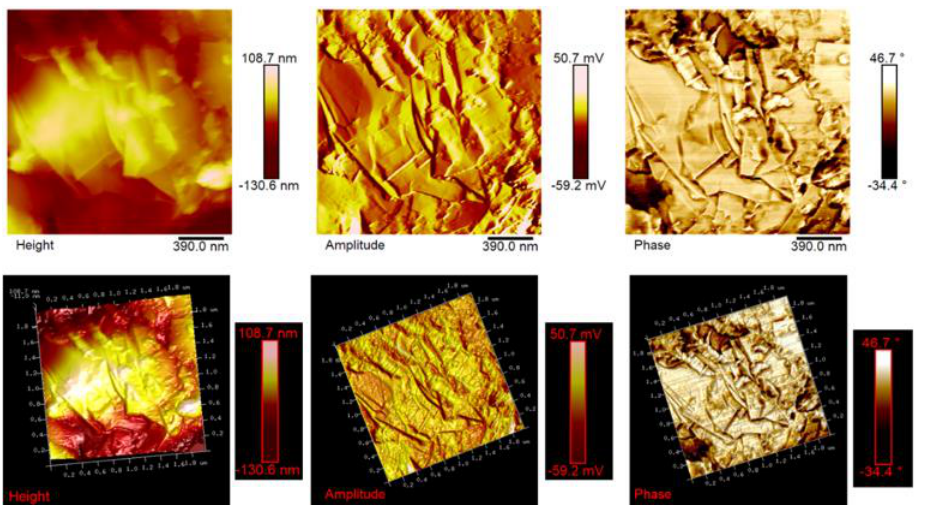
Figure 12. Tapping mode AFM micrographs of the fracture surface of the TBD + 3%EG sample (see on the top) and the corresponding 3D profiles (see on the bottom).